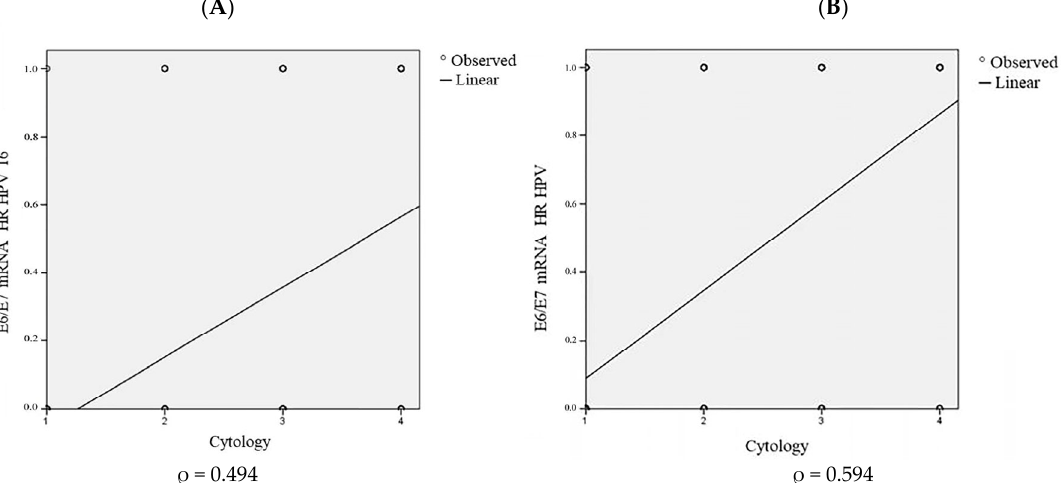
Figure 6. Correlation between the oncogenic activity of the HPV 16 genotype and cytology ( A ) and overall HPVs’ oncogenic activity and cytology ( B ). NILM (1), ASCUS (2), LSIL (3), HSIL (4), and Spearman’s correlation coefficient ( ρ ).